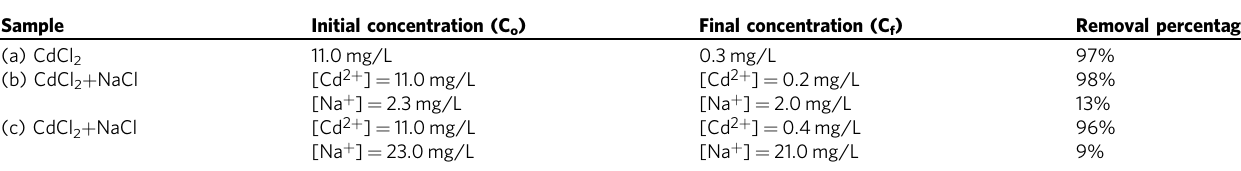
Table 1 Changes of ion concentration of different aqueous solutions containing sodium and cadmium cations after interacting with Na fi on